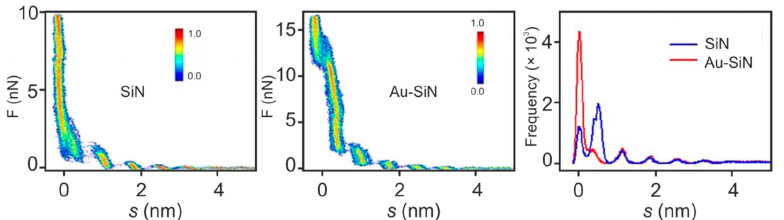
Figure 10. Force–separation curves and separation histogram measured during approach of the [EMIm][TFSI] / mica interface using comparing a SiN and a Au-coated SiN tip. Adapted from Black et al. [20].